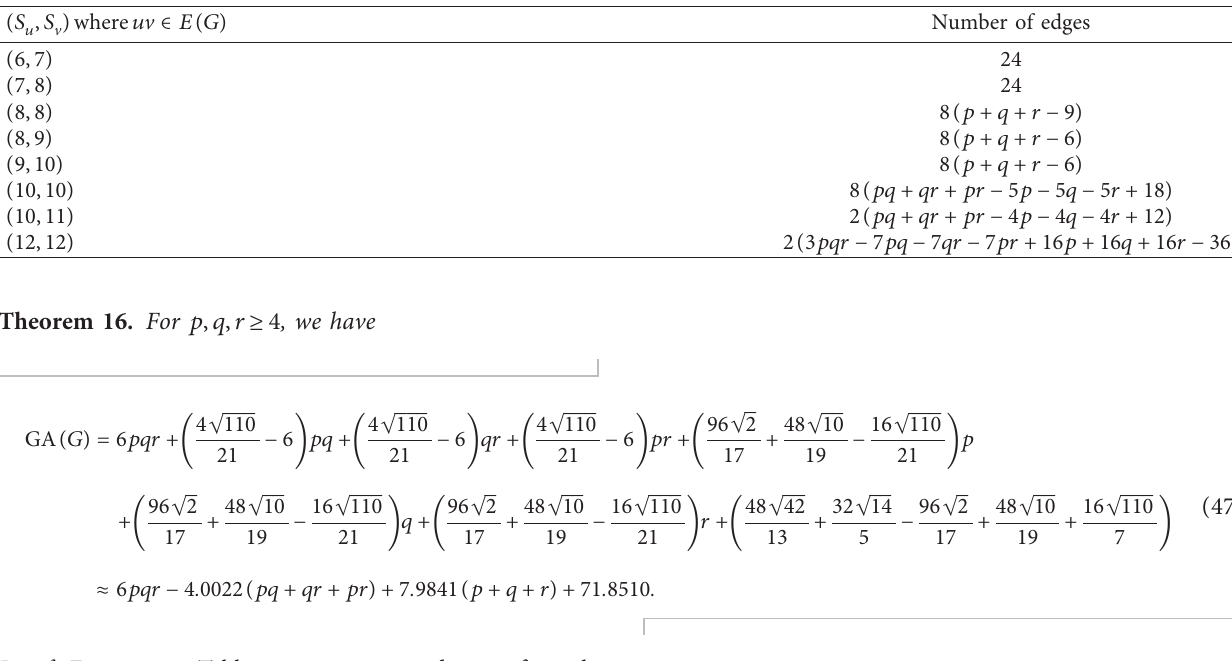
Table 8: Edge partition of RO ( p, q,r ) centered on vertices’ degree sum which is present at distance unite from the final (end) vertices of each